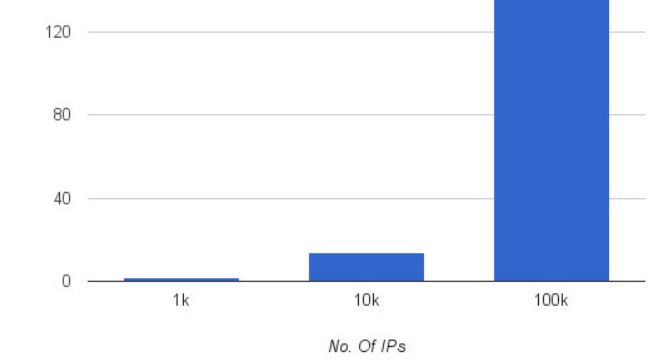
Figure 10. Effect of payload size on processing delays.